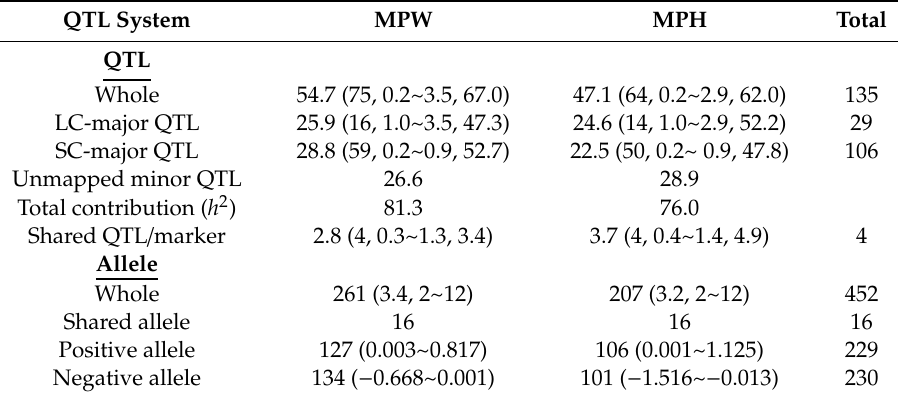
Table 4. The detected QTL-allele system that confers drought tolerance in the CCSP. QTL System MPW MPH